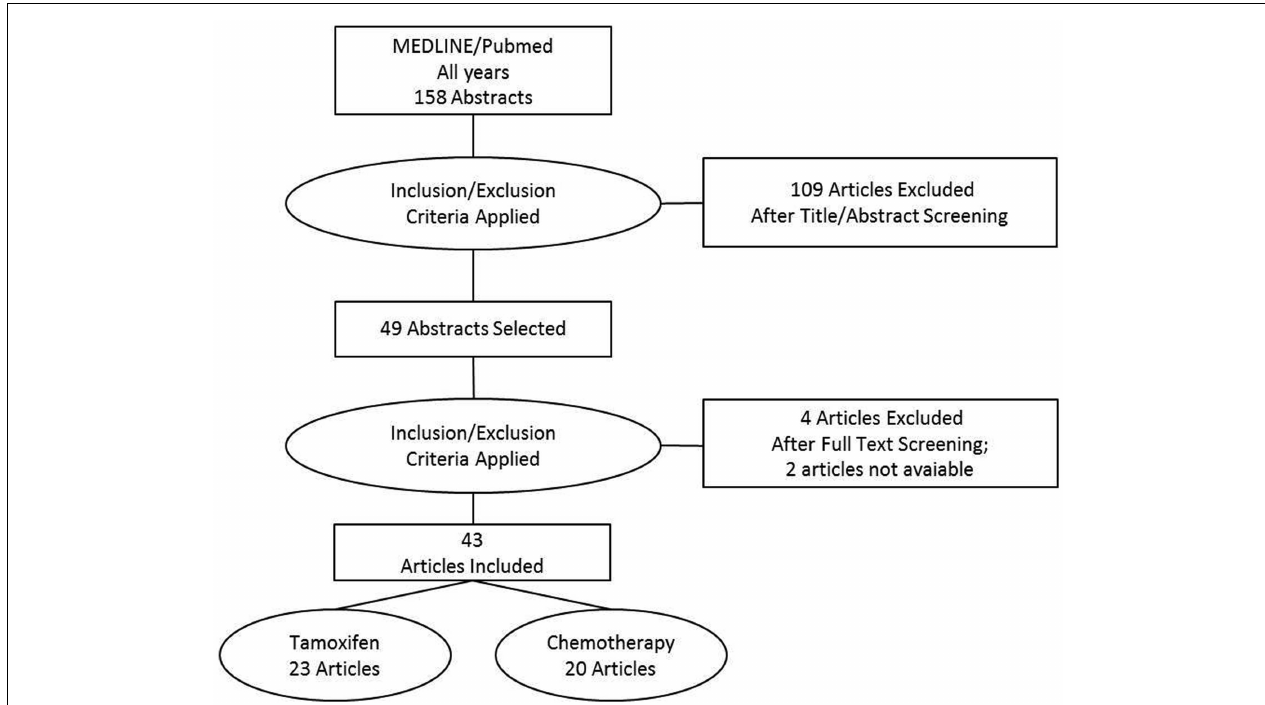
FIGURE 1 | Flow chart of the systematic review of literature